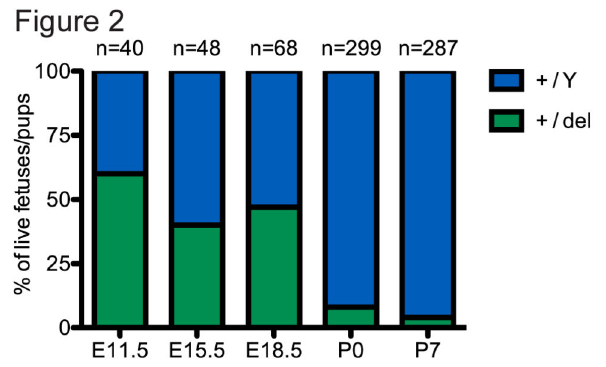
Figure 2. Analysis of survival of Porcn +/del fetuses and neonates. At fetal stages (E11.5 to E18.5) Porcn +/del females were observed at the expected Mendelian frequency (50%). At birth (P0) only 7.4% of the live neonates observed were female. Lethality in the first week of life further reduced this frequency to 3.5% (10 out of 277 expected) at postnatal day 7 (P7). doi: